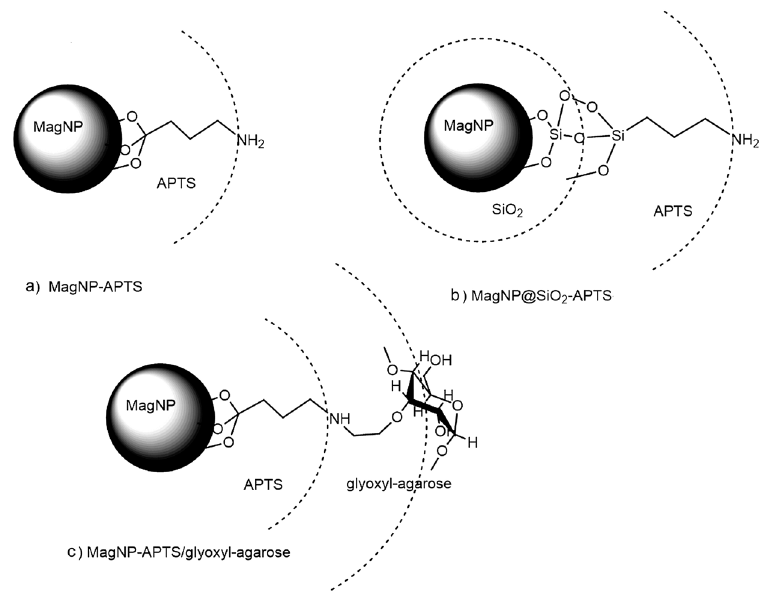
Figure 1 - Functionalized magnetic nanoparticles: a) MagNP-APTS, b) MagNP@ SiO -APTS and c) MagNP-APTS/glyoxyl-agarose. 2